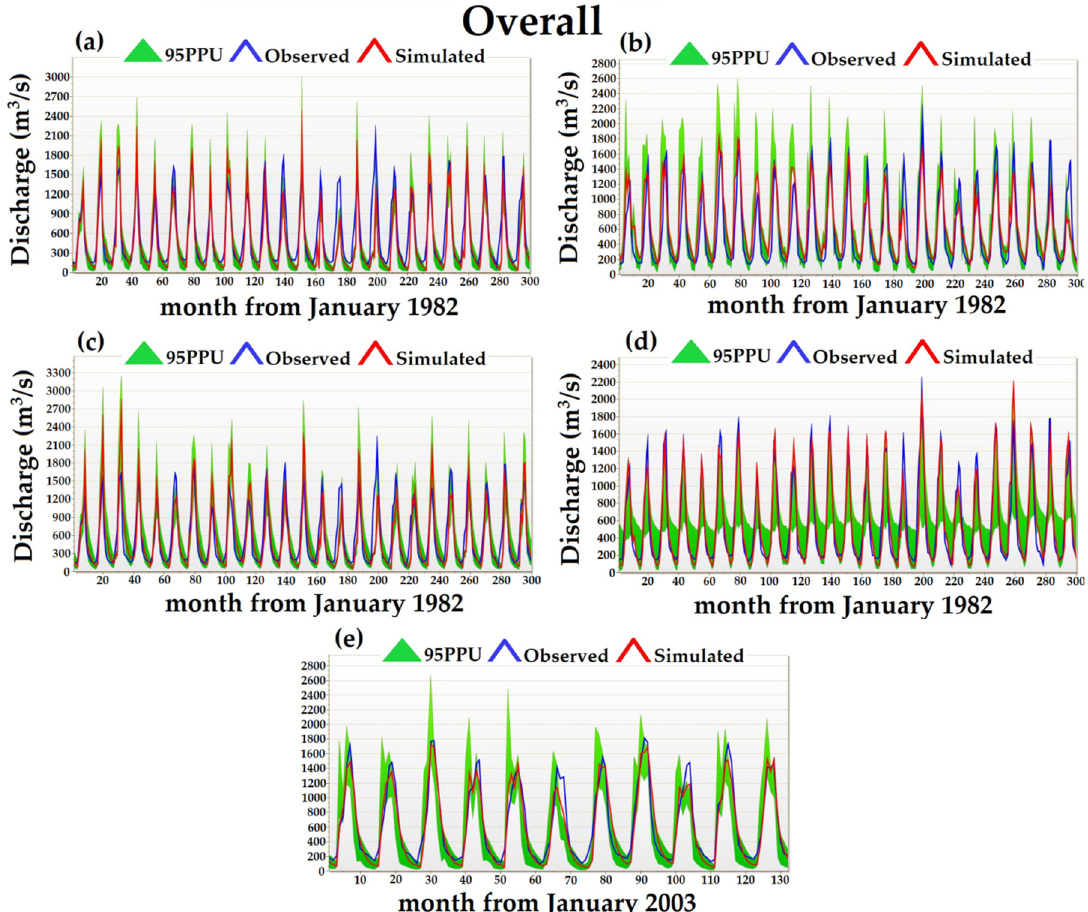
Figure 7. Hydrograph of the overall calibration and validation period between monthly observed and simulated streamflow, when applying the SWAT–CUP tool, at Darband gauging station in the Upper Vakhsh River Basin in Central Asia. ( a ) Results of the daily precipitation of the APHRODITE_V1101 and daily maximum/minimum temperatures from the CFSR datasets; ( b ) results of the daily precipitation of the APHRODITE_V1101 and daily maximum/minimum temperatures of the CRU TS3.1 product; ( c ) results of the daily maximum/minimum temperatures, precipitation, average solar radiation, average wind speed and relative humidity from the CFSR product; ( d ) results of the daily maximum/minimum temperatures, precipitation from the CRU TS3.1 product; ( e ) results of the daily maximum/minimum temperatures and precipitation from the observational climate datasets.